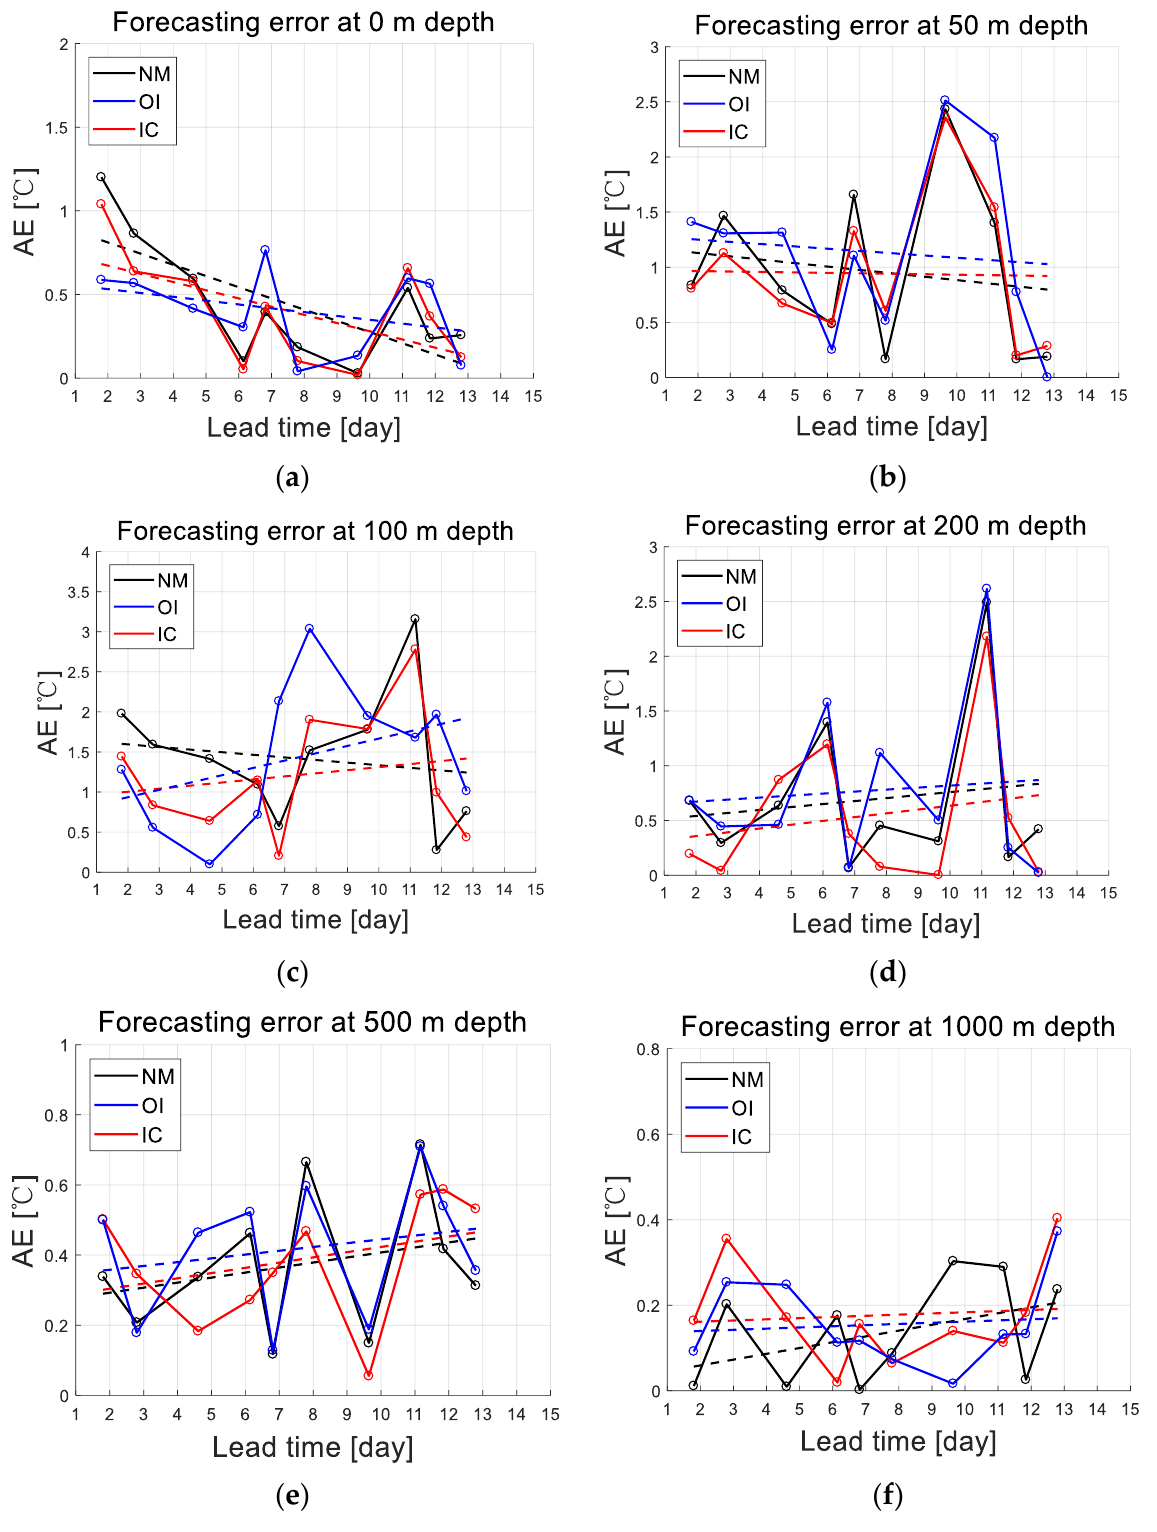
Figure 6. Temperature forecasting error of Experiment 2. ( a ) 0 m; ( b ) 50 m; ( c ) 100 m; ( d ) 200 m; ( e ) 500 m; ( f ) 1000 m. The black line is the forecasting error of the original numerical model (NM), the blue line is the forecasting error of the OI, the red line is the forecasting error of the IC and the dashed line is the error regression line.